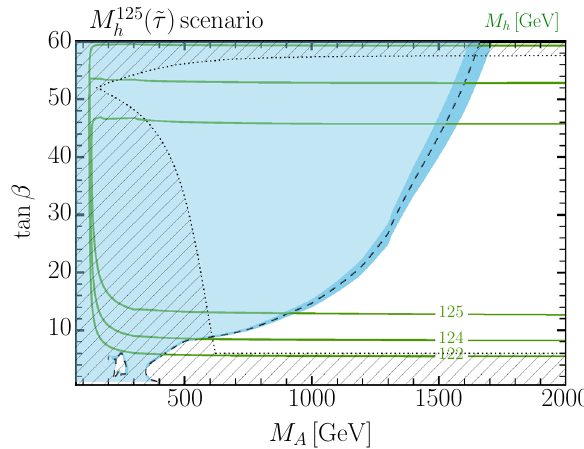
( ˜ τ) scenario from Higgs searches at the Fig. 2 Constraints on the M 125 h LHC, in the ( M A , tan β) plane. The green solid lines are predictions for the mass of the lighter CP -even scalar h , the hatched area is excluded by a mismatch between the properties of h and those of the observed Higgsboson,andtheblueareaisexcludedbythesearchesforadditional Higgs bosons (the darker-blue band shows the theoretical uncertainty of the exclusion)